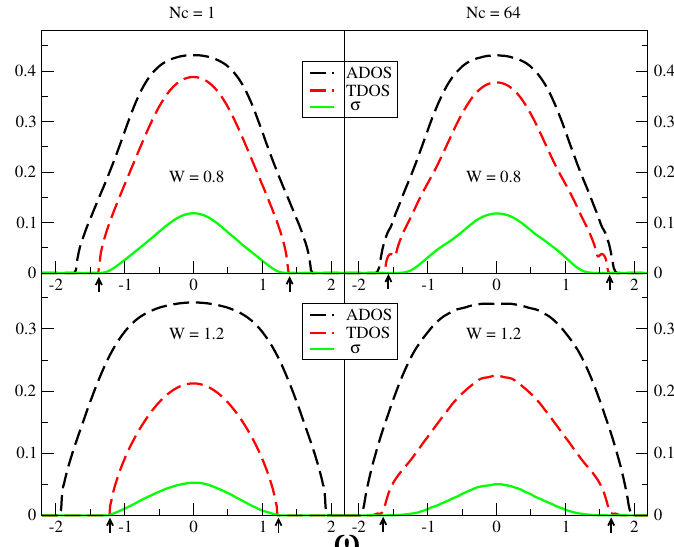
Figure 38. The evolution of the ADOS, TDOS and DC conductivity of the single-band 3D Anderson model at various disorder strengths W for the single-site TMT and the TMDCA with cluster size N c = 64. Here, for the DC conductivity, ω corresponds to the chemical potential used in the calculation. Arrows indicate the position of the mobility edge, which separates the extended electronic states from the localized ones. Reprint from [190].